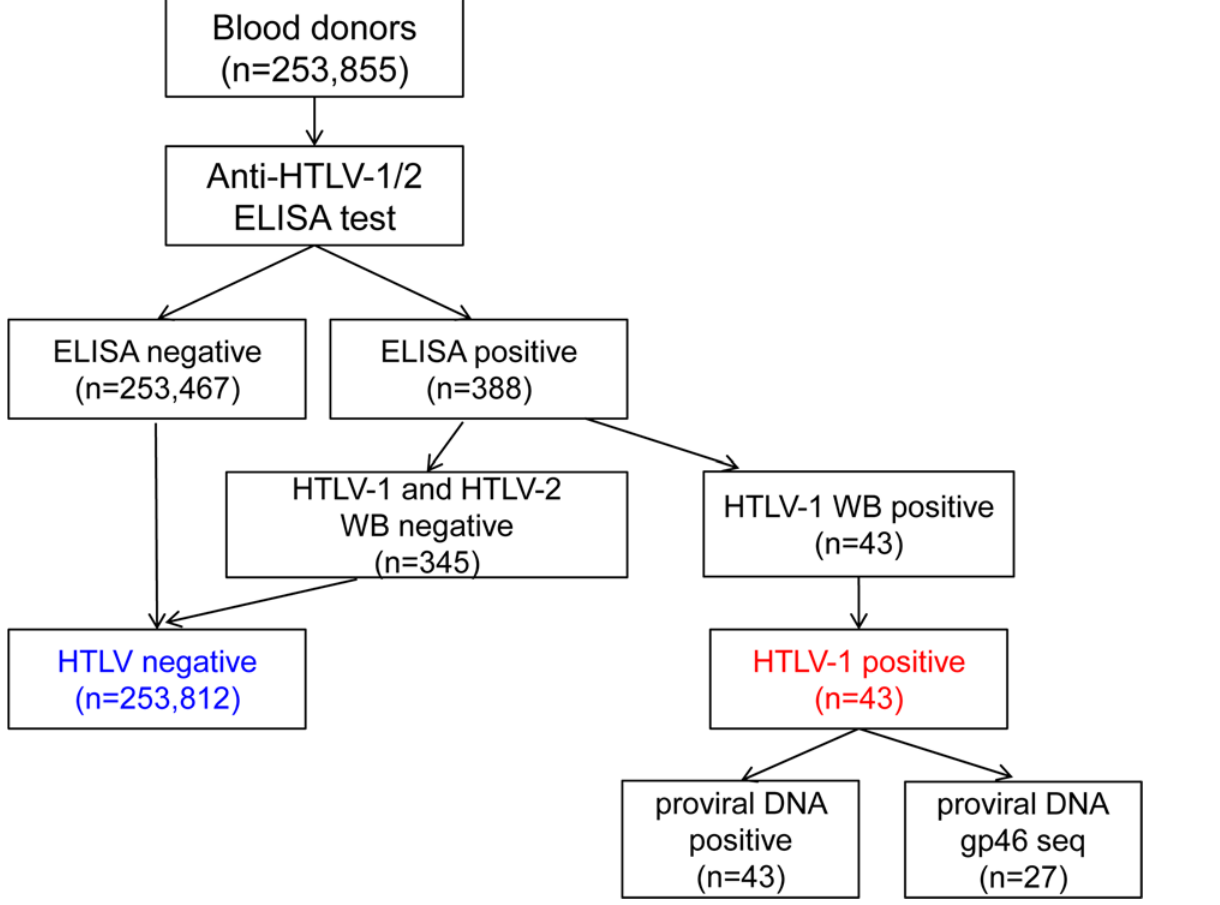
Fig 1. Flow chart of screening and confirmation of HTLV